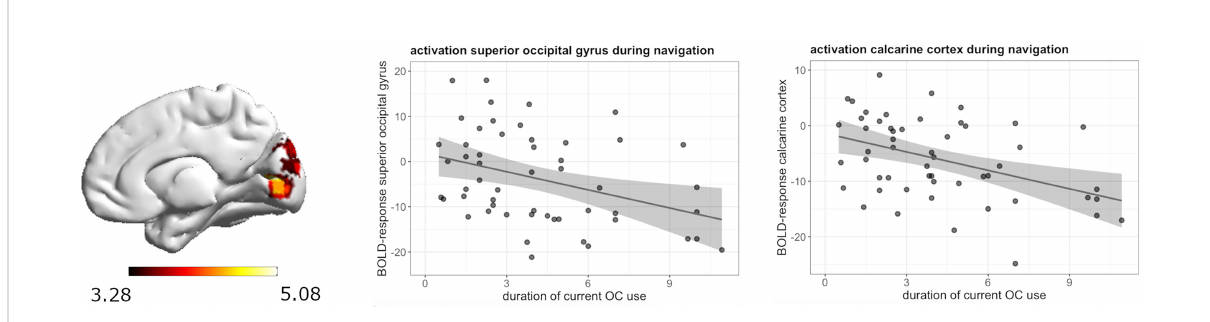
FIGURE 4 Negative association between duration of OC use and right superior occipital gyrus and right calcarine cortex deactivation during navigation in current OC